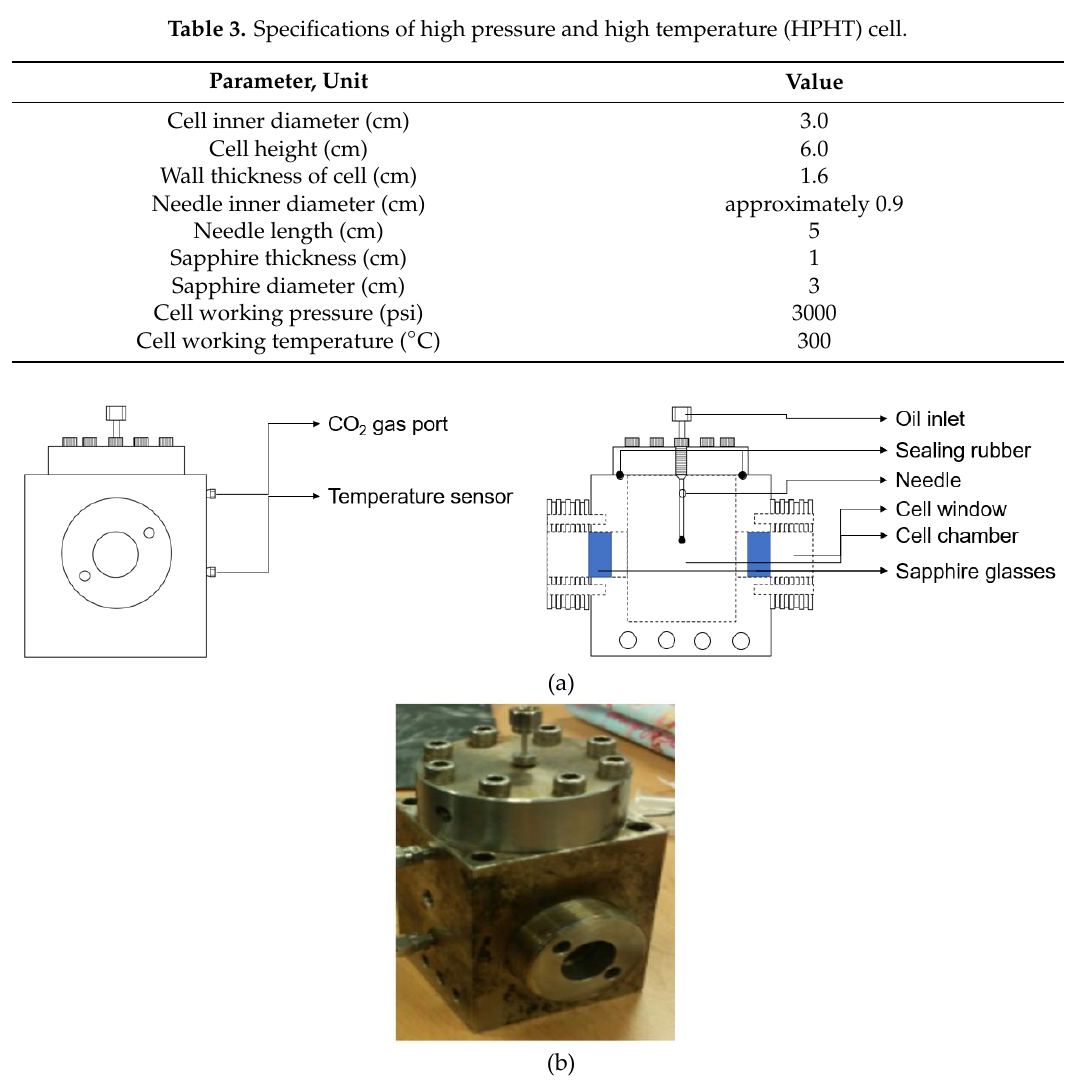
Table 3. Specifications of high pressure and high temperature (HPHT) cell. 171